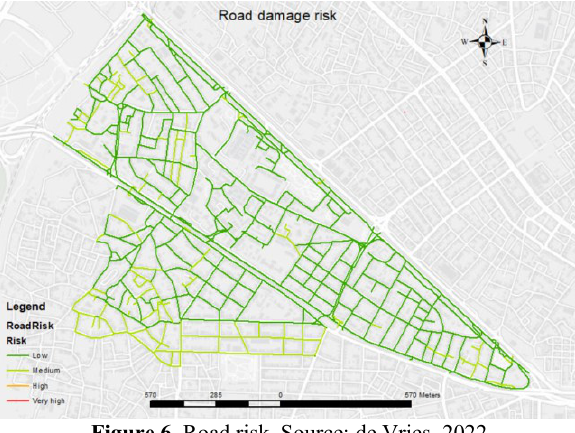
Figure 6 . Road risk. Source: de Vries,